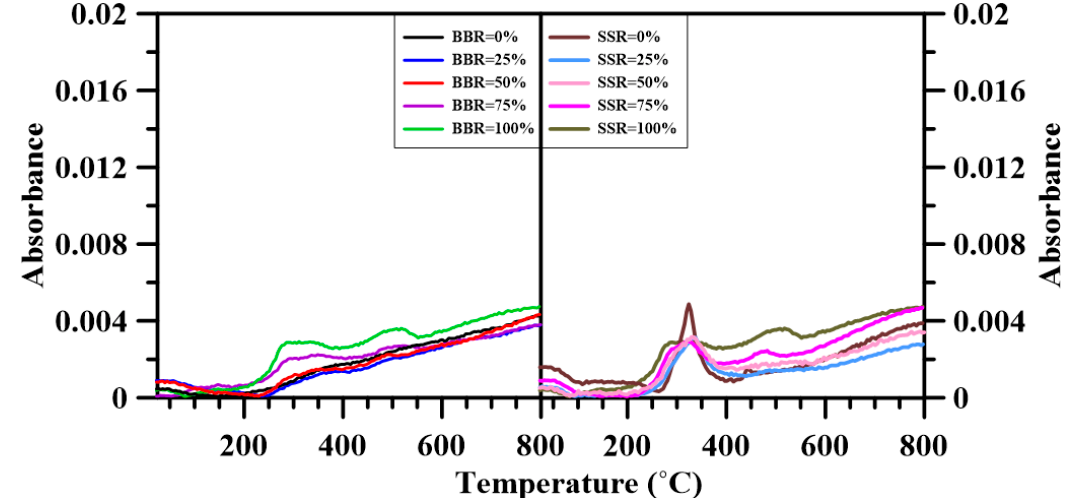
Figure 14. Evolution of SO 2 for various sludge-coal and sludge-shiitake ratios in TGA-FTIR.